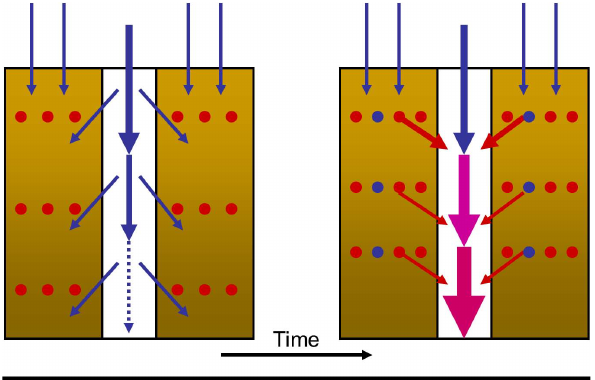
Fig. 7. Conceptual flow model of the field soil. Brown color indi- cates the soil matrix, the white box a preferential flow path. Red color indicates old water, blue color indicates new/irrigation water. Violet indicates mixed waters. At the beginning of the experiment (left) irrigation water infiltrates in the soil matrix at the surface and via macropores, only a small amount of irrigation water reaches the tile drain. With increasing storage in the system soil water enters the preferential flow paths and mixes there with irrigation water. Mostly old water reaches the tile